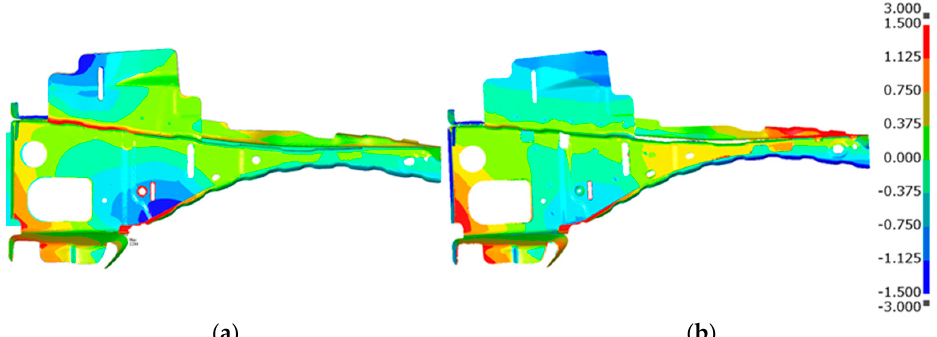
Figure 14. Welding deformation (mm). ( a ) Predicted; ( b ) Measured.